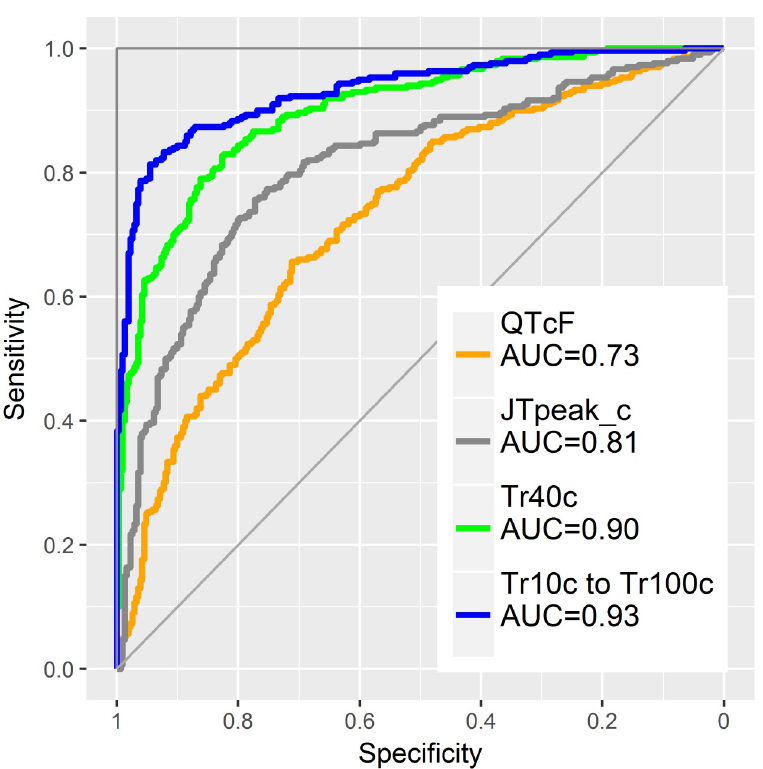
Fig 9. Classification of pure hERG/iKr current block versus multichannel block in logistic regression models. The separation performance (AUC) of the heart rate corrected T vector trajectory quantile Tr40c (green curve) and the combined 10 Tr X quantiles (blue curve) are compared to QTcF (orange curve) and to published [16] J-T peak c data (grey curve).